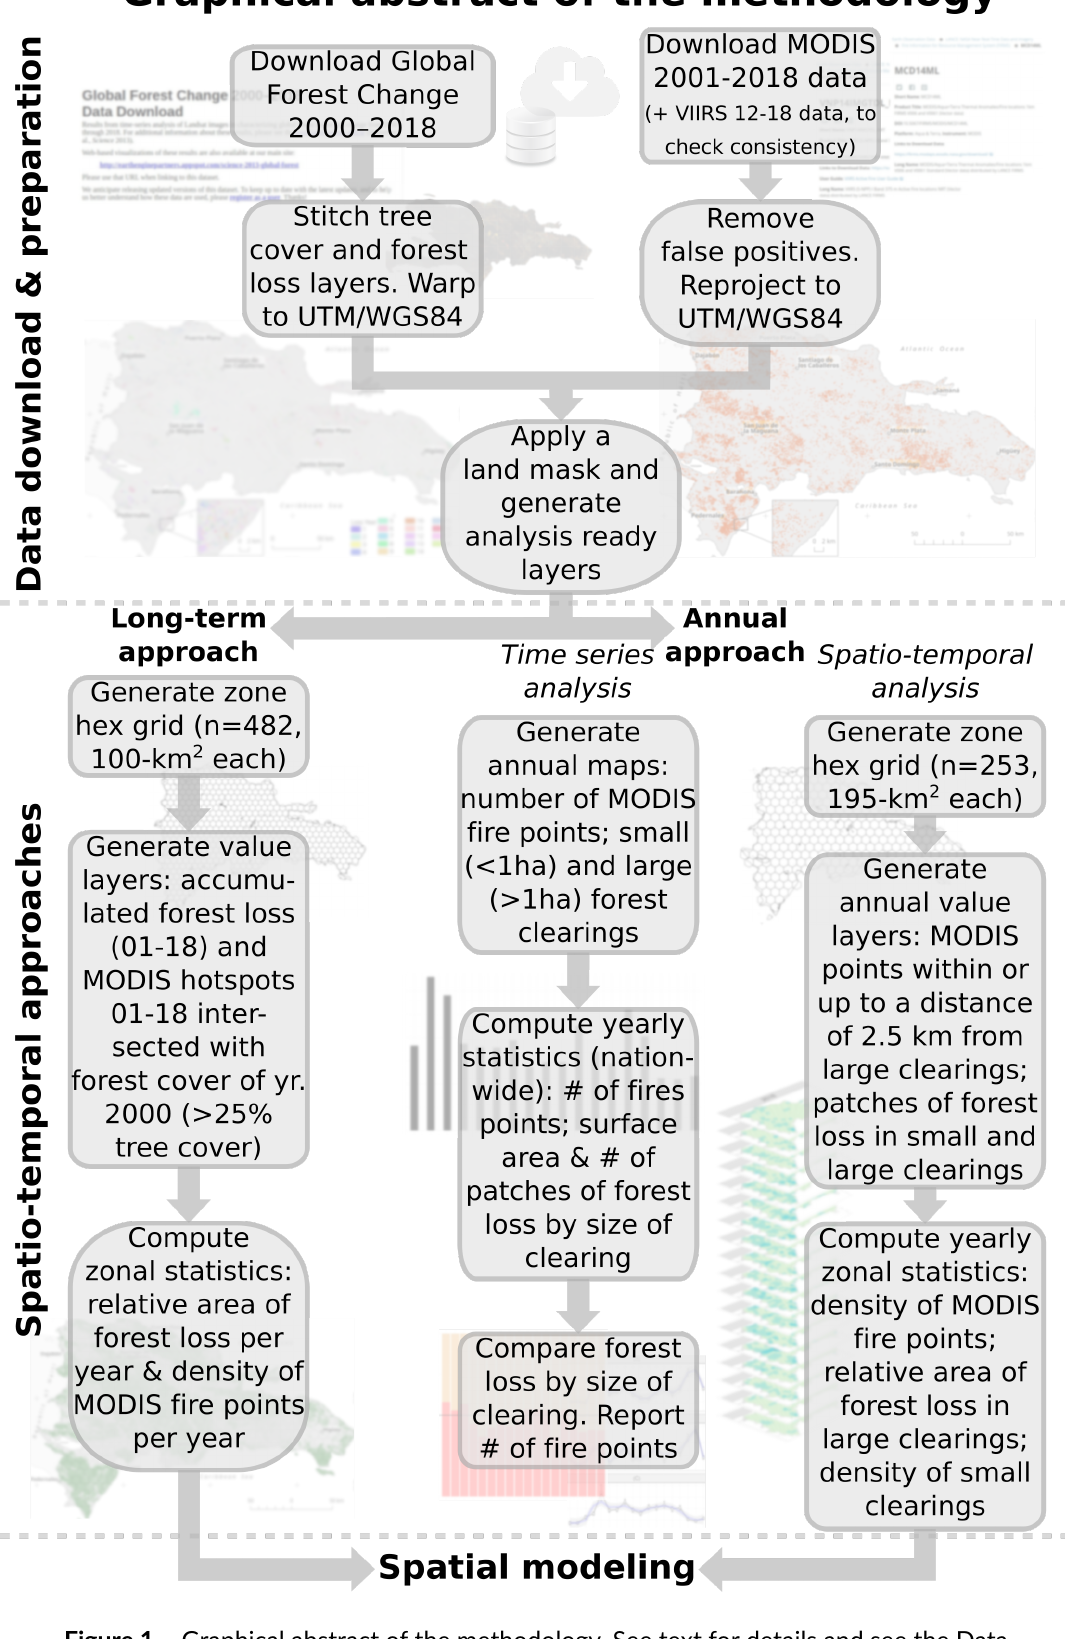
Figure 1 – Graphical abstract of the methodology. See text for details and see the Data and code availability section for provided